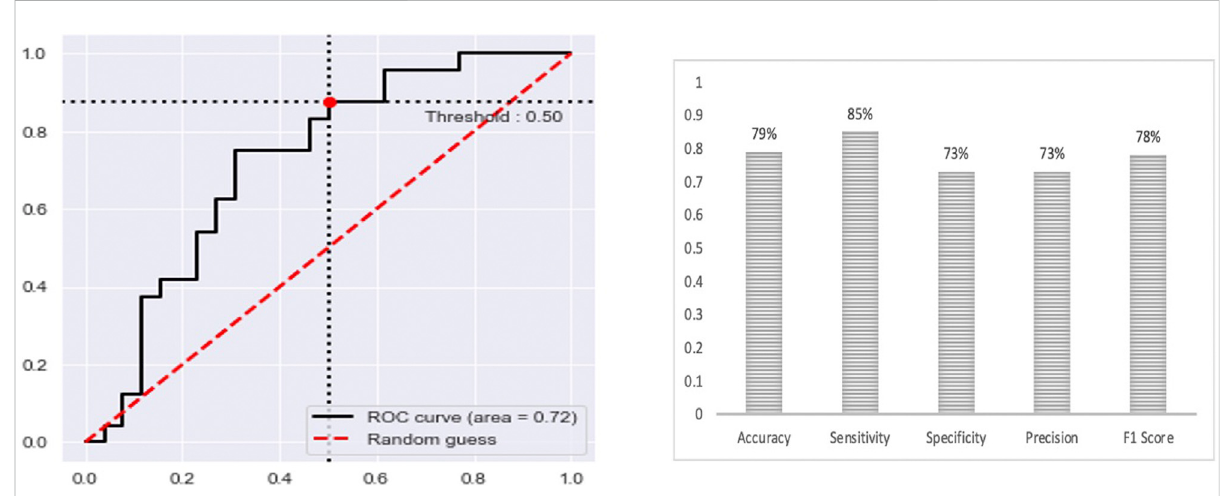
FIGURE 7 The prediction performance of the fi nal multi-class DNN model using a speci fi c population-based